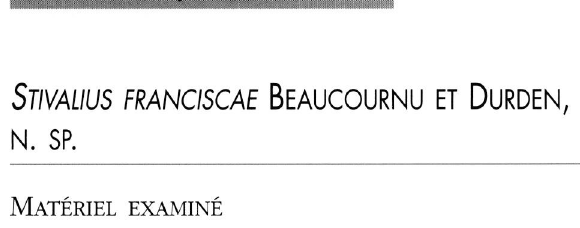
apical du sternite : ces soies sont relativement longues.